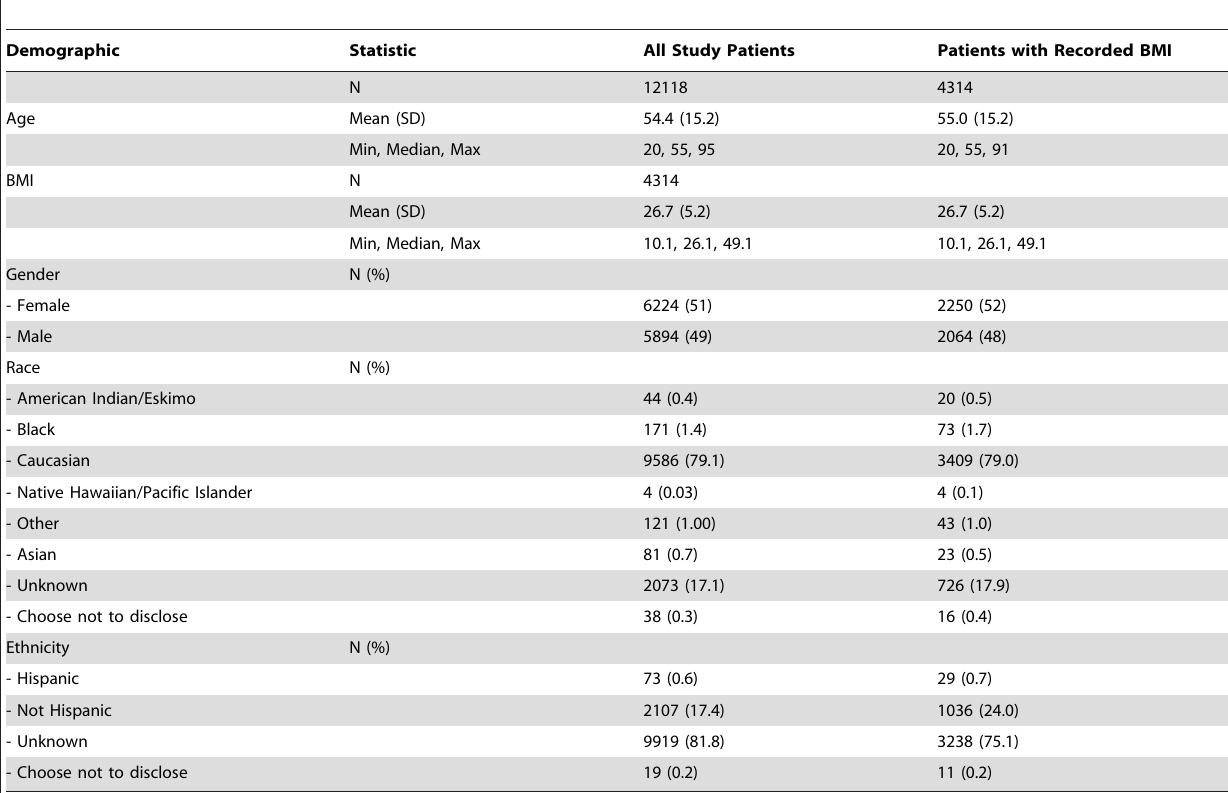
Table 2. Demographics and disposition of study patients following final screening.